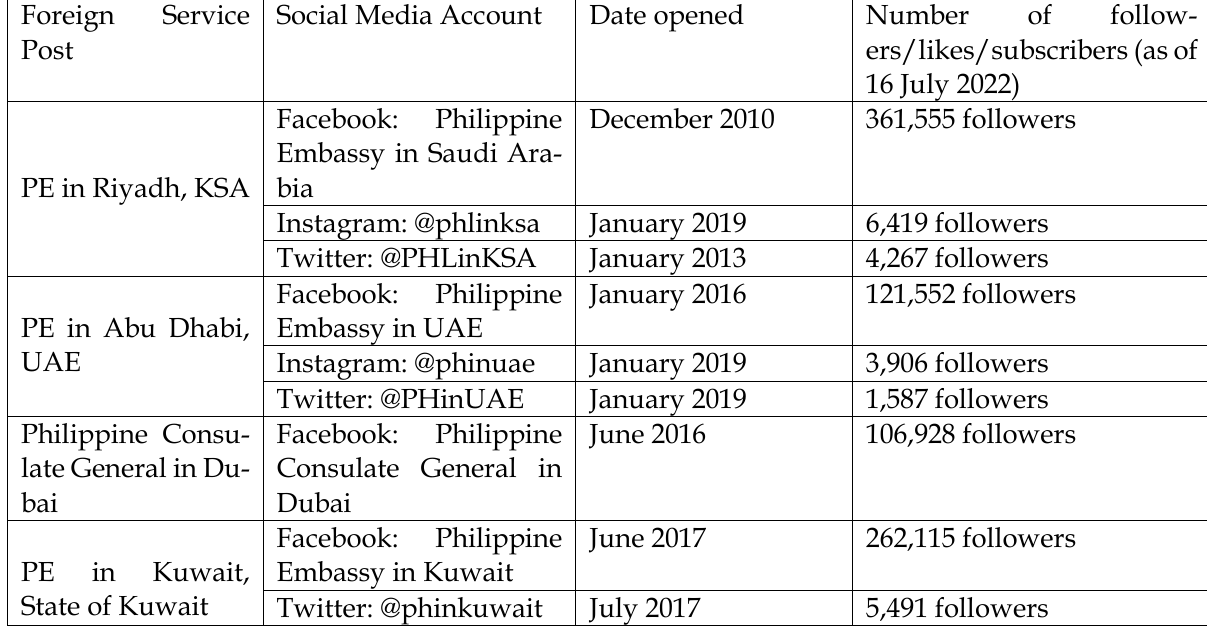
Table 2: Social Media Presence of Philippine Foreign Service